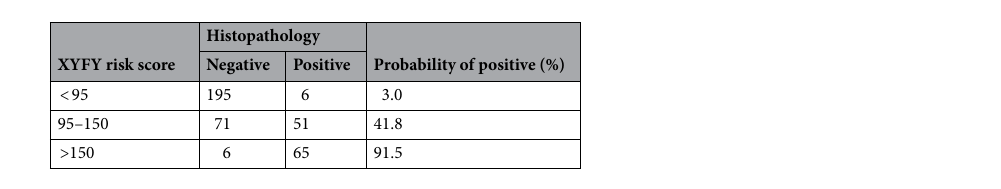
Table 3. XYFY risk model for predicting the outcomes of